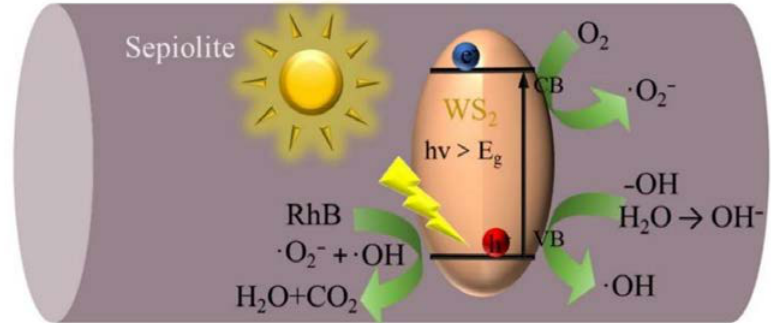
Figure 6. Possible RhB degradation mechanism of the WS 2 /Sep composite.